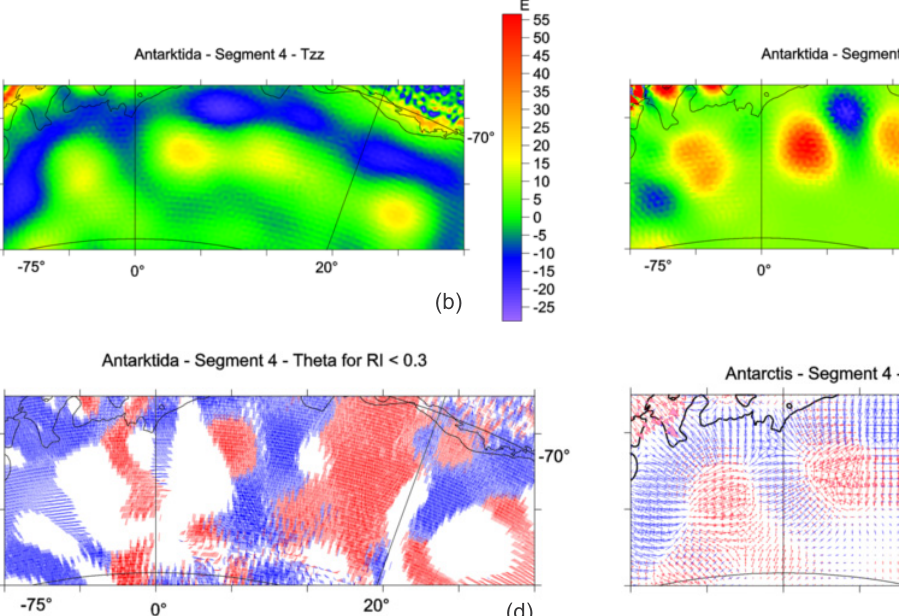
Figure 15. Segment 4: (a) the topography from Bedmap2, a general view, (b) T